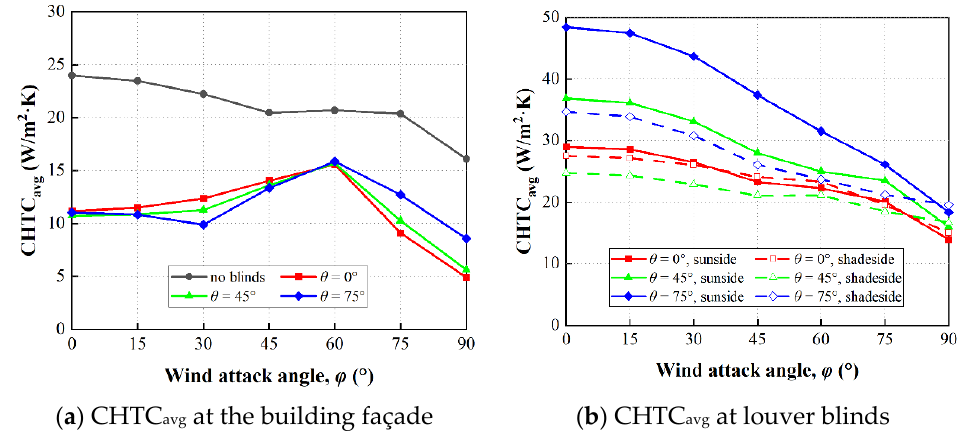
Figure 12. The comparison of CHTC avg at the façade and louvers among different louver angles θ ( U ref = 3.41 m/s, D = 0.05 H , B / H = 0.035, T H − T a = 10 °C, T B − T a = 20 °C). ( U ref = 3.41 m/s, D = 0.05 H , B / H = 0.035, T H